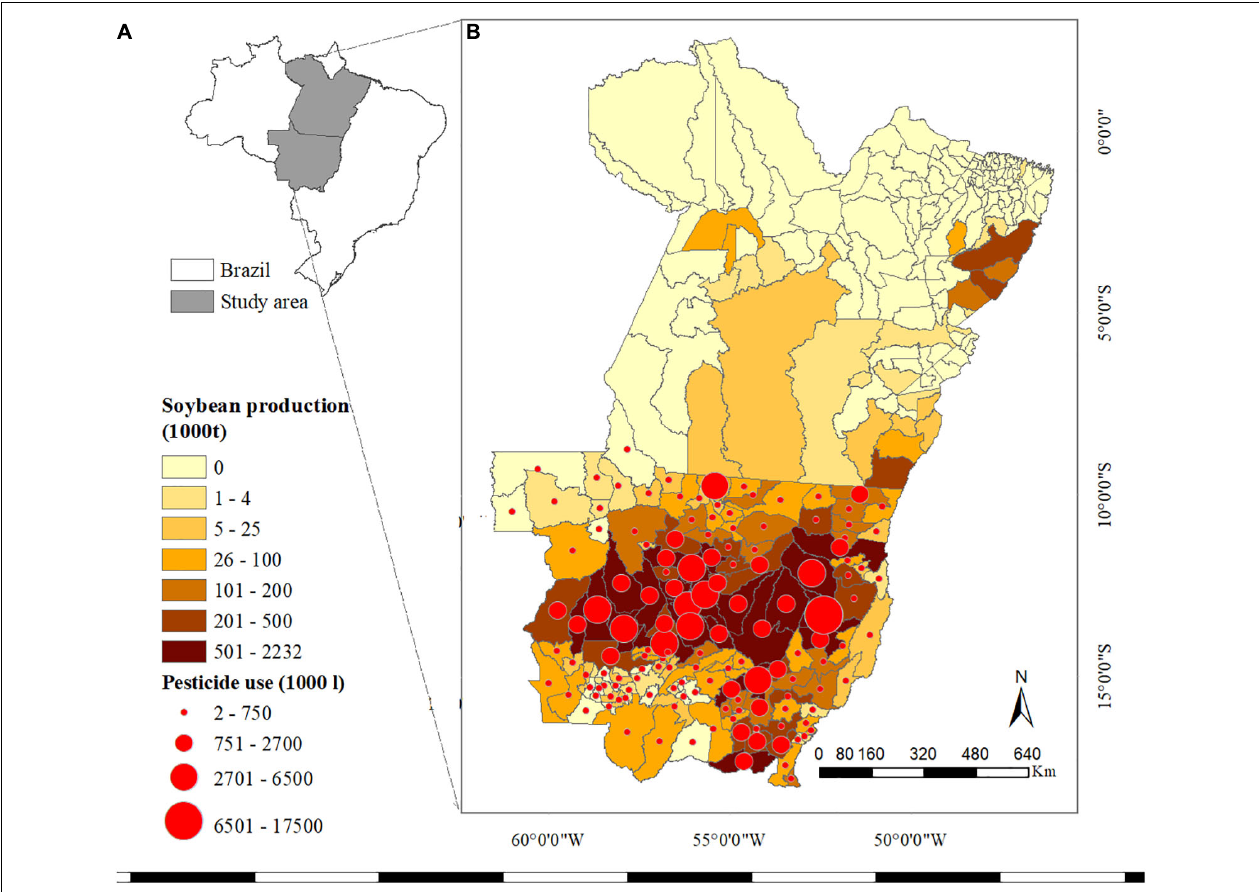
FIGURE 1 | (A) Study of area within Brazil. (B) Soybean production by municipality in Mato Grosso and Pará in thousands of tonnes in 2018, as well as pesticide use in litres in MT. IBGE (2019b), INDEA (2020). Maps created using ArcMap 10.6.1.